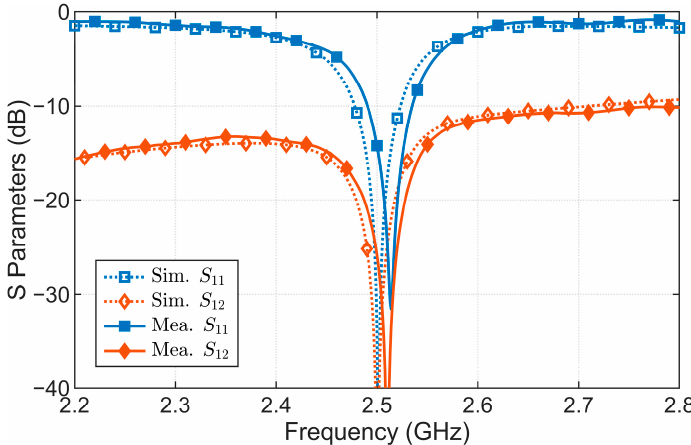
Figure 12. The S parameters of the decoupled array.